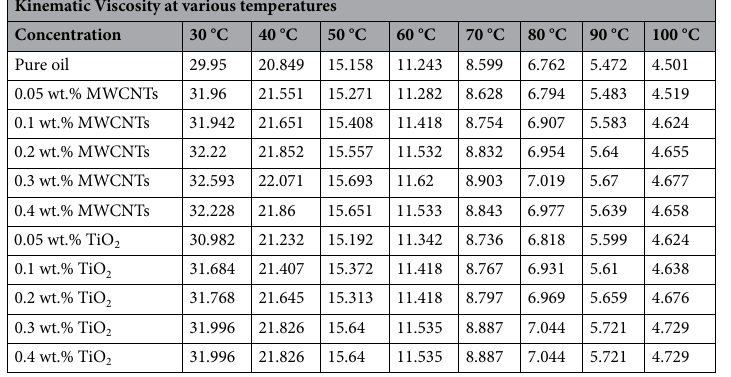
Table 4. Comparison of the kinematic viscosity for TiO 2 /turbine meter oil and MWCNTs/turbine meter oil lubricants at different temperatures.